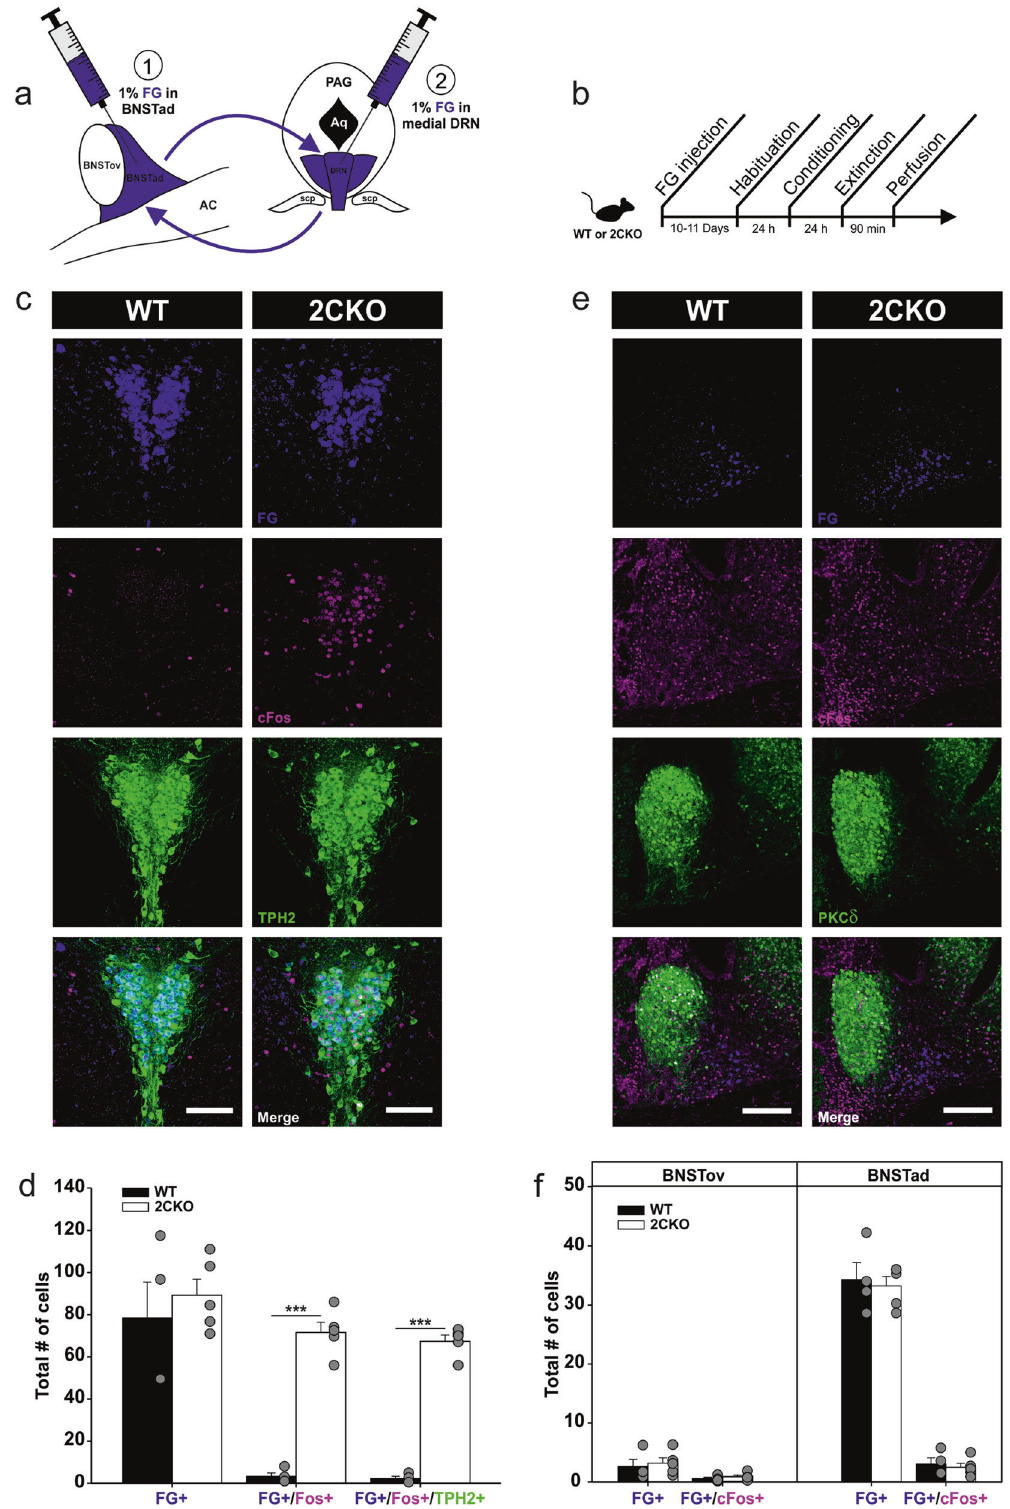
the DRV of the rostral DRN (Fig. 2b, magenta box), the most signi fi cant genotype effect was found in the DRC of the caudal DRN (Fig. 2d, magenta box). For the rostral DRV, extinction treatment had no effect on cFos in WT mice, whereas 2CKO mice displayed increased cFos levels in TPH2 + 5-HT cells